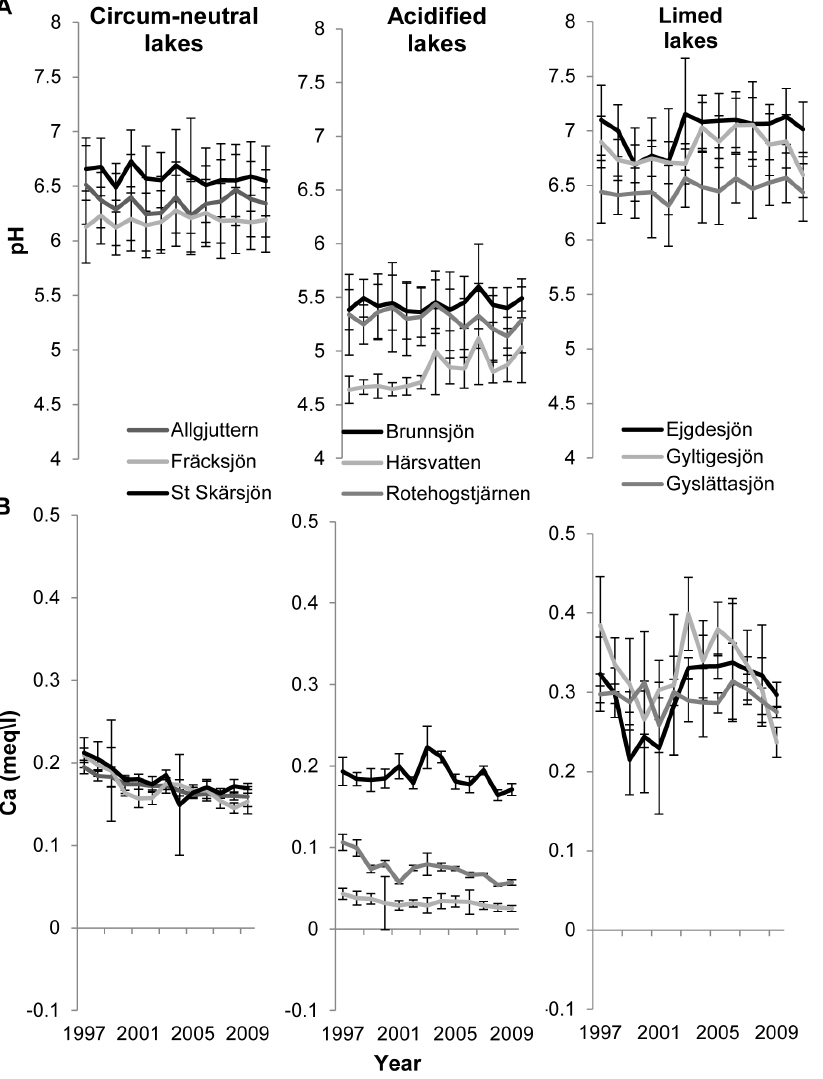
Figure 2. Selected water quality variables: (a) pH and (b) calcium concentration between 1997 and 2009 in circum-neutral acidified and limed lakes. Shown are the overall patterns (mean 6 SE) for the different lakes.